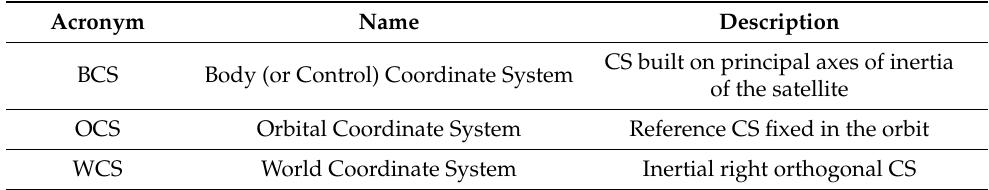
Table 1. Coordinate